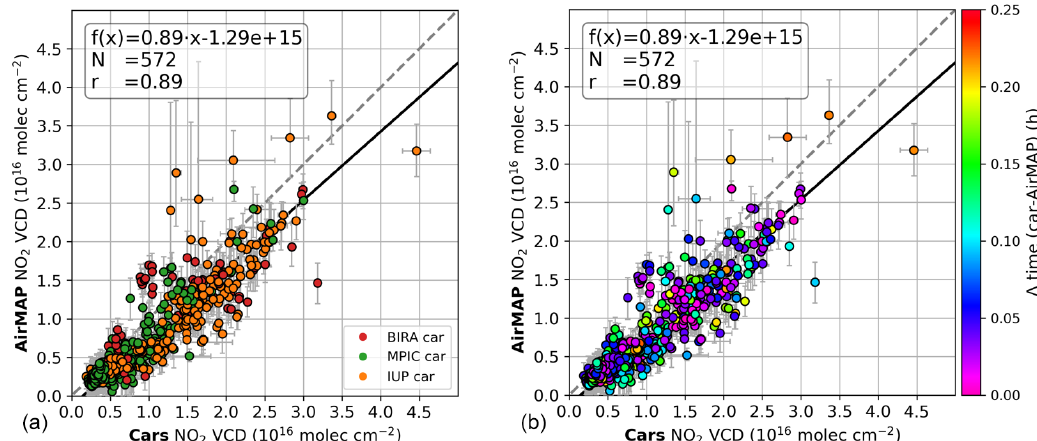
Figure A7. Similar to Fig. 7 but with different error bars. Scatter plots showing co-located car DOAS ( ± 15min window from the aircraft overpass) and AirMAP NO 2 VCDs using grid boxes of 500m × 500m and 15min time intervals. The data points from BIRA, MPIC, and IUP car DOAS instruments are color coded as red, green, and orange, respectively (a ). The color coding in panel (b) shows the time difference between the AirMAP and car DOAS measurements. Error bars represent the 10th and 90th percentile within the 500m × 500m grid boxes and 15min time intervals.